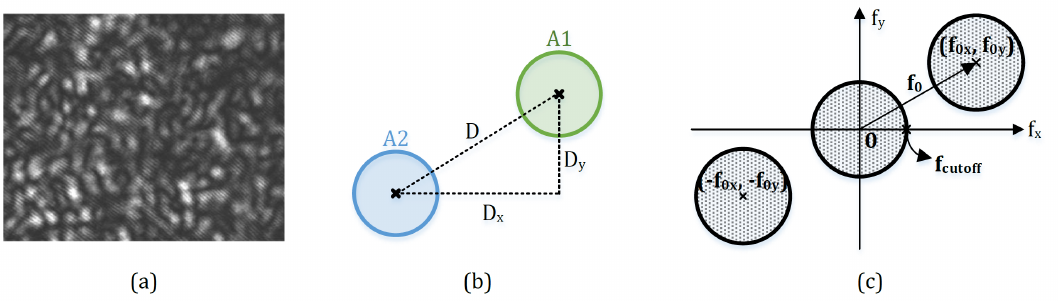
Figure 4. ( a ) speckle grains with internal spatial fringe structure; ( b ) relative positions of the virtual images of two single apertures in the detector’s plane; ( c ) corresponding spectrum distribution of the speckle pattern in the frequency